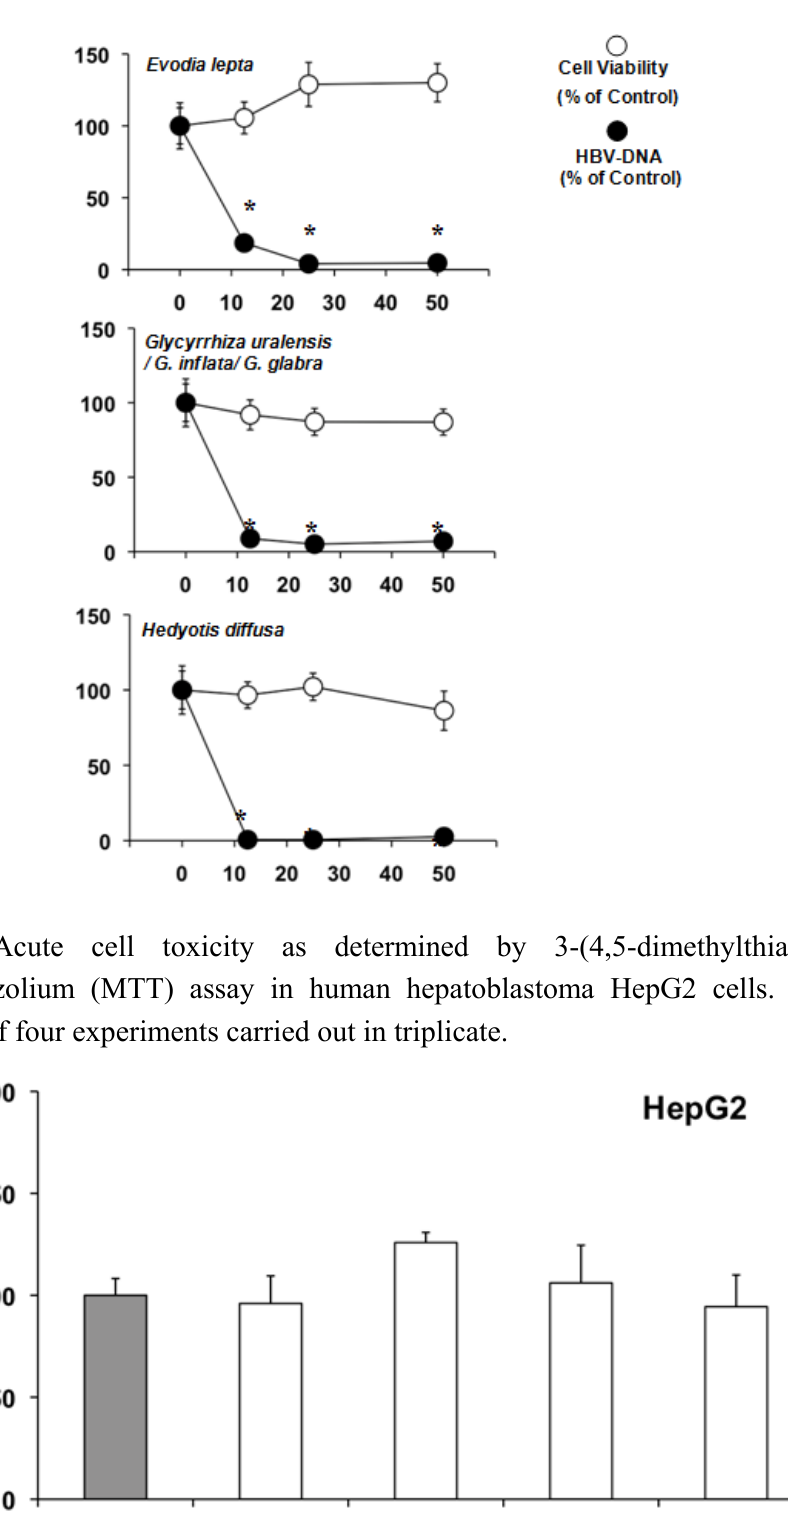
Figure 1. Effect of water extracts on hepatitis B virus (HBV) release as determined by HBV-DNA content in the culture medium and cell viability as determined by Neutral Red uptake by human hepatoblastoma cells HepG2 2.2.15 infected with HBV. Values are means ± SD of three experiments carried out in triplicate by incubation with the extracts for 21 days. *, p < 0.05 as compared with untreated cells by paired t -test.